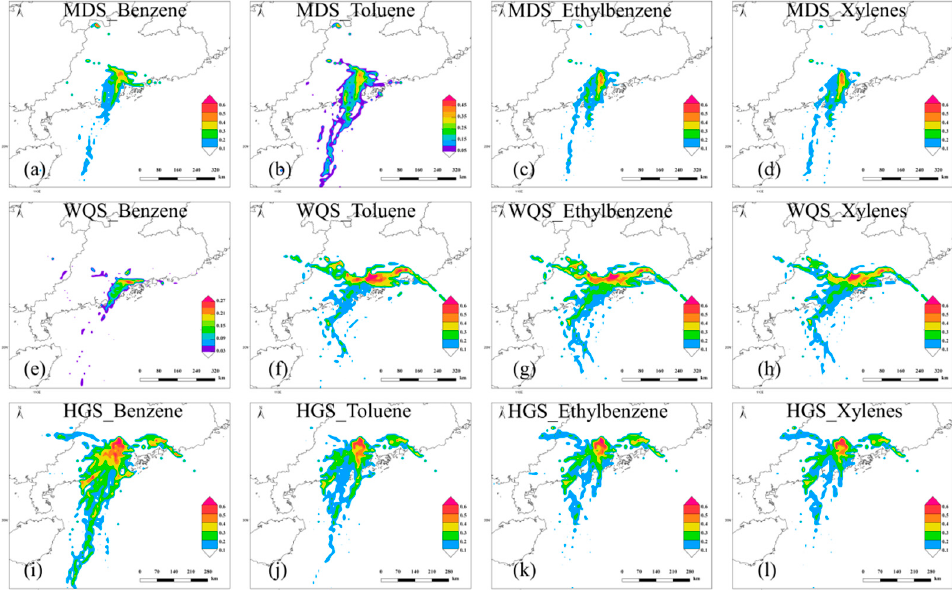
Figure 12. The PSCF analysis for potential source areas of ( a ) benzene at MDS, ( b ) toluene at MDS, ( c ) ethylbenzene at MDS, ( d ) xylenes at MDS, ( e ) benzene at WQS, ( f ) toluene at WQS, ( g ) ethylbenzene at WQS, ( h ) xylenes at WQS, ( i ) benzene at HGS, ( j ) toluene at HGS, ( k ) ethylbenzene at HGS, and ( l ) xylenes at HGS.